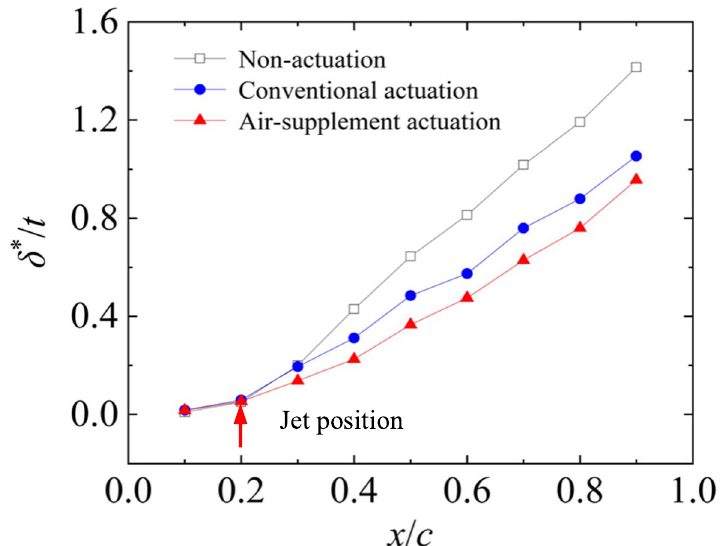
Fig. 17 Boundary layer displacement thickness under different actuation states